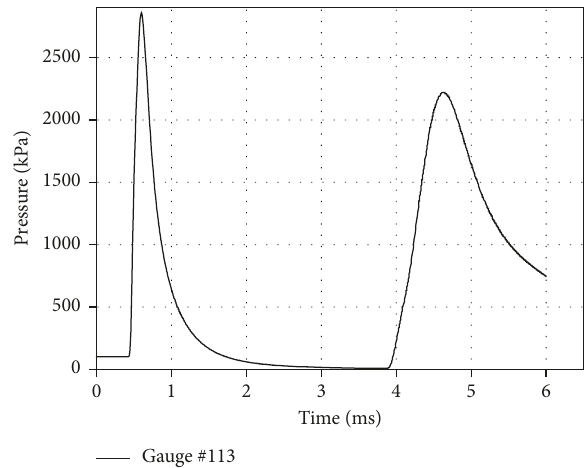
Figure 18: Velocity-time history of Gauge